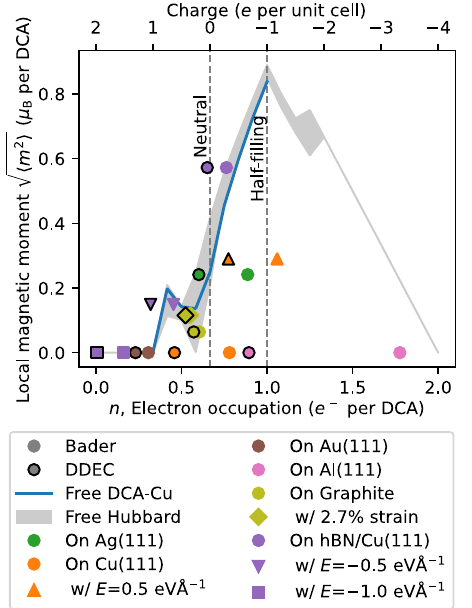
Fig. 3 Charge transfer and local magnetic moments of DCA-Cu MOF (free-standing and on substrates) and under different conditions, calculated using DFT + U . These local magnetic moments lead to magnetically ordered phases (Figs. 2 and 5). Two different charge partitioning methods set bounds for the MOF- substrate charge transfer: Bader 77 and DDEC 79,80 . Two other methods (Supplementary Notes 3 and 4) give values between the Bader and DDEC results (Supplementary Fig. 1). E refers to the electric- fi eld applied normal to the substrate. The grey shaded region marks the results calculated within the mean- fi eld Hubbard model with a single unit cell, without a substrate, and with interaction parameter U H between 6 t and 7 t , presented for comparison with the DFT-calculated free-standing results.